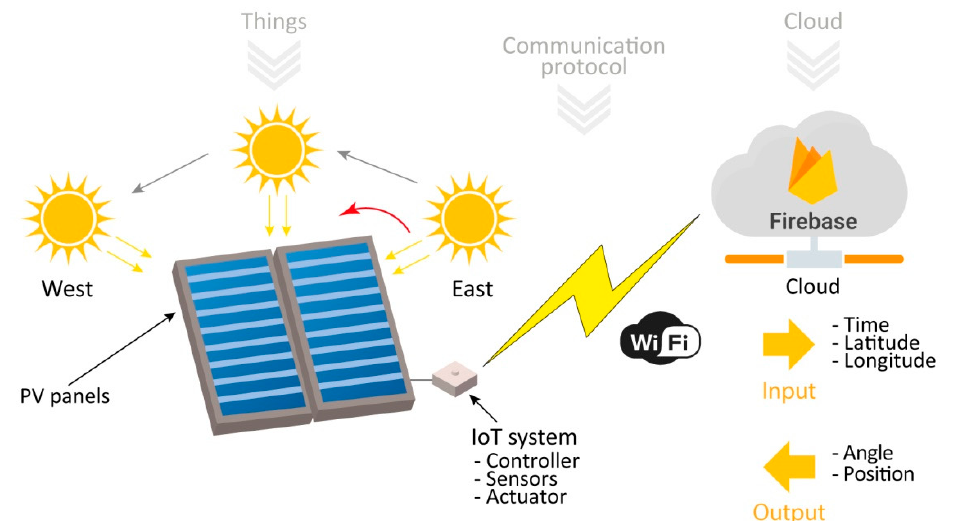
Figure 7. General Internet of Things (IoT) architecture of the system.